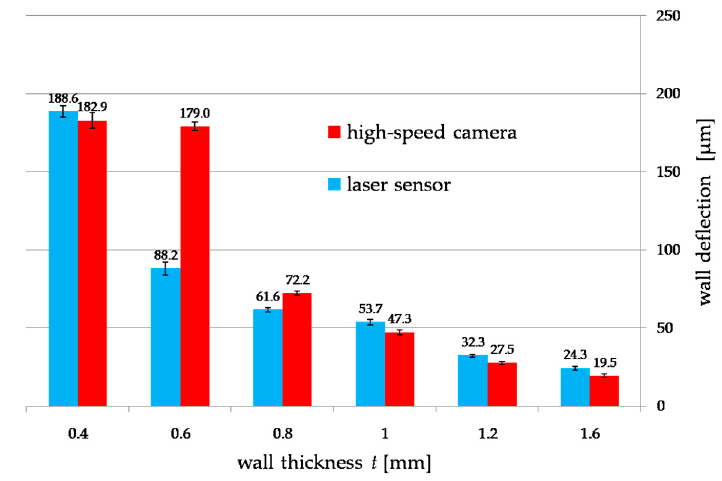
Figure 12. Measurement uncertainty when measuring thin walled workpiece deflection with a high-speed camera and displacement laser sensor.